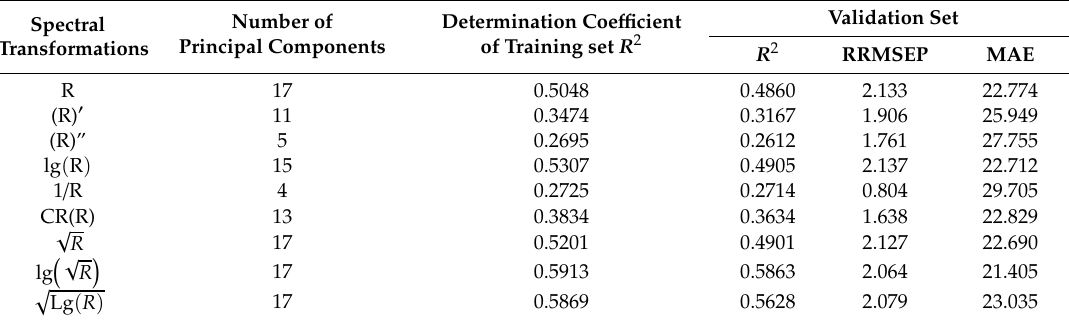
Table 3. Partial least square (PLS) model accuracy of di ff erent transform spectra.